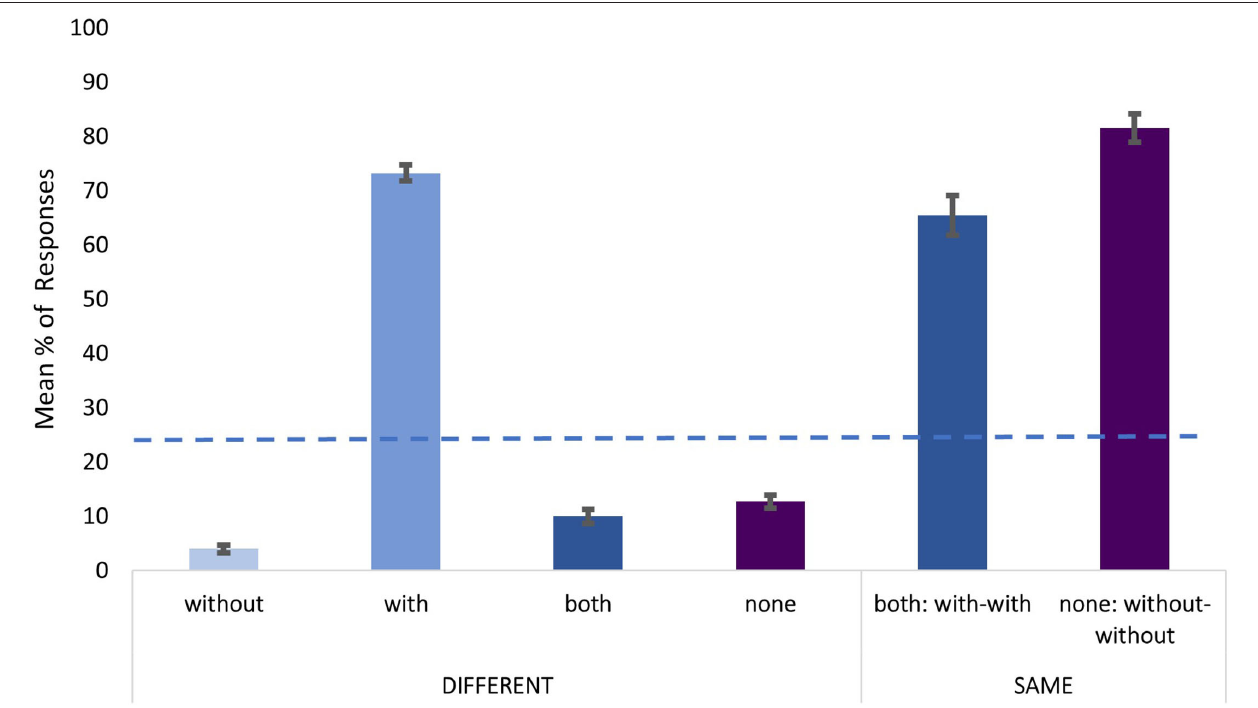
FIGURE 2 | Responses observed in the direct-question task across different and same trial pairs. Error bars represent standard error of mean ( + /– 1). The dashed line represents the chance level